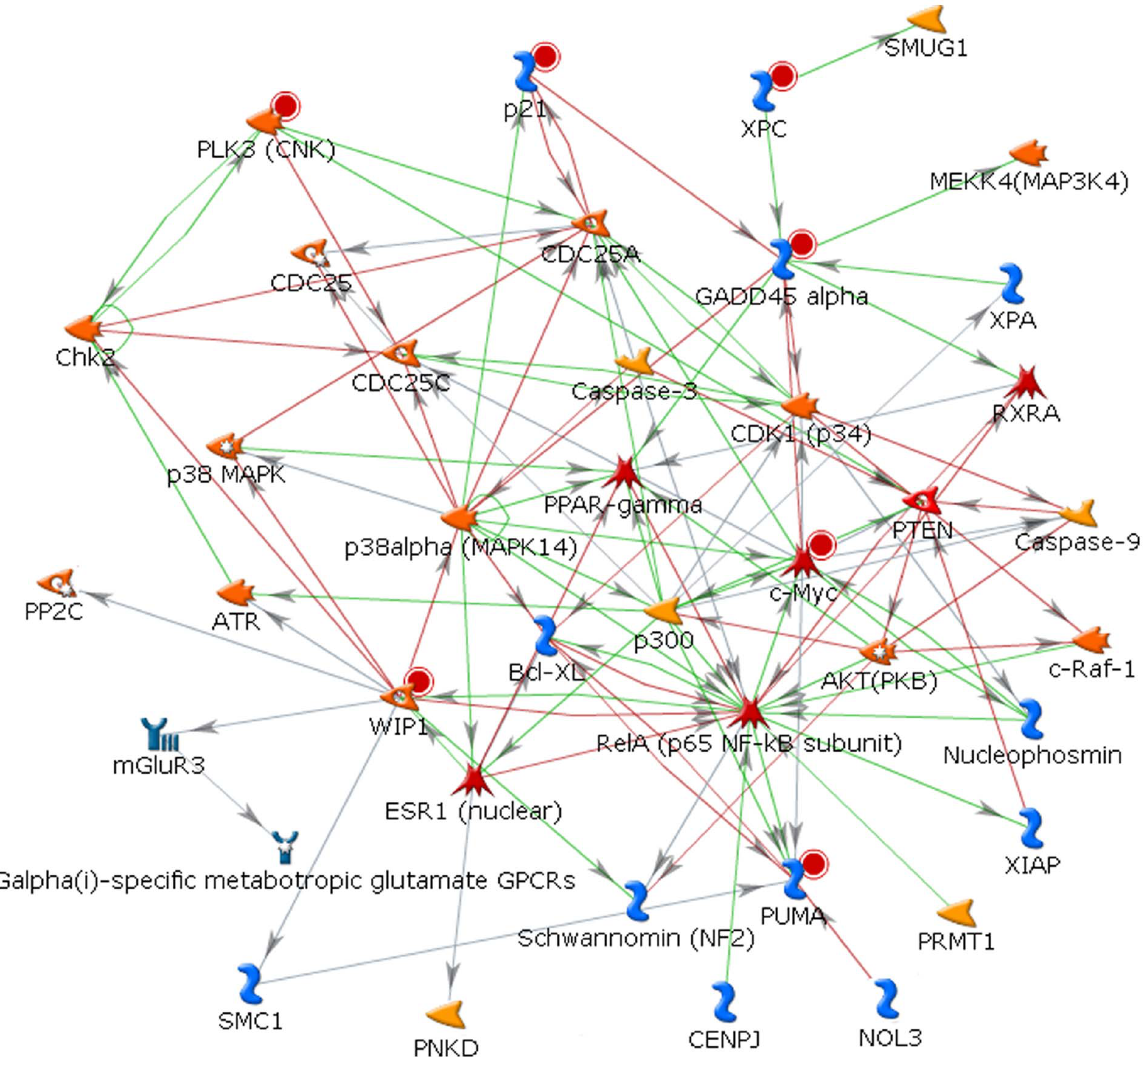
Figure 5. The most probable interaction network when 20 genes were entered into MetaCore software. The resulting interacting network uses only 7 genes. Red, green, and gray lines indicate inhibitory, stimulatory, and unspecified interactions, respectively.